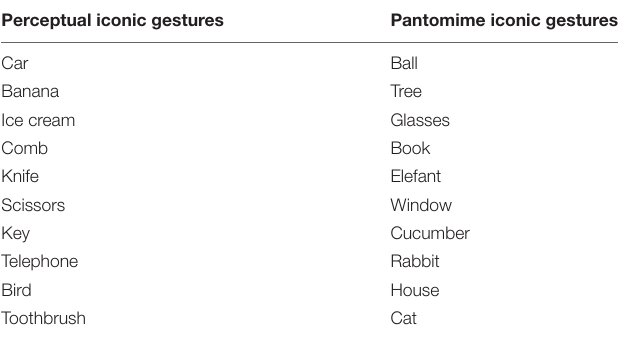
TABLE 1 | Perceptual and pantomime iconic gestures of the iconic gesture test. Perceptual iconic